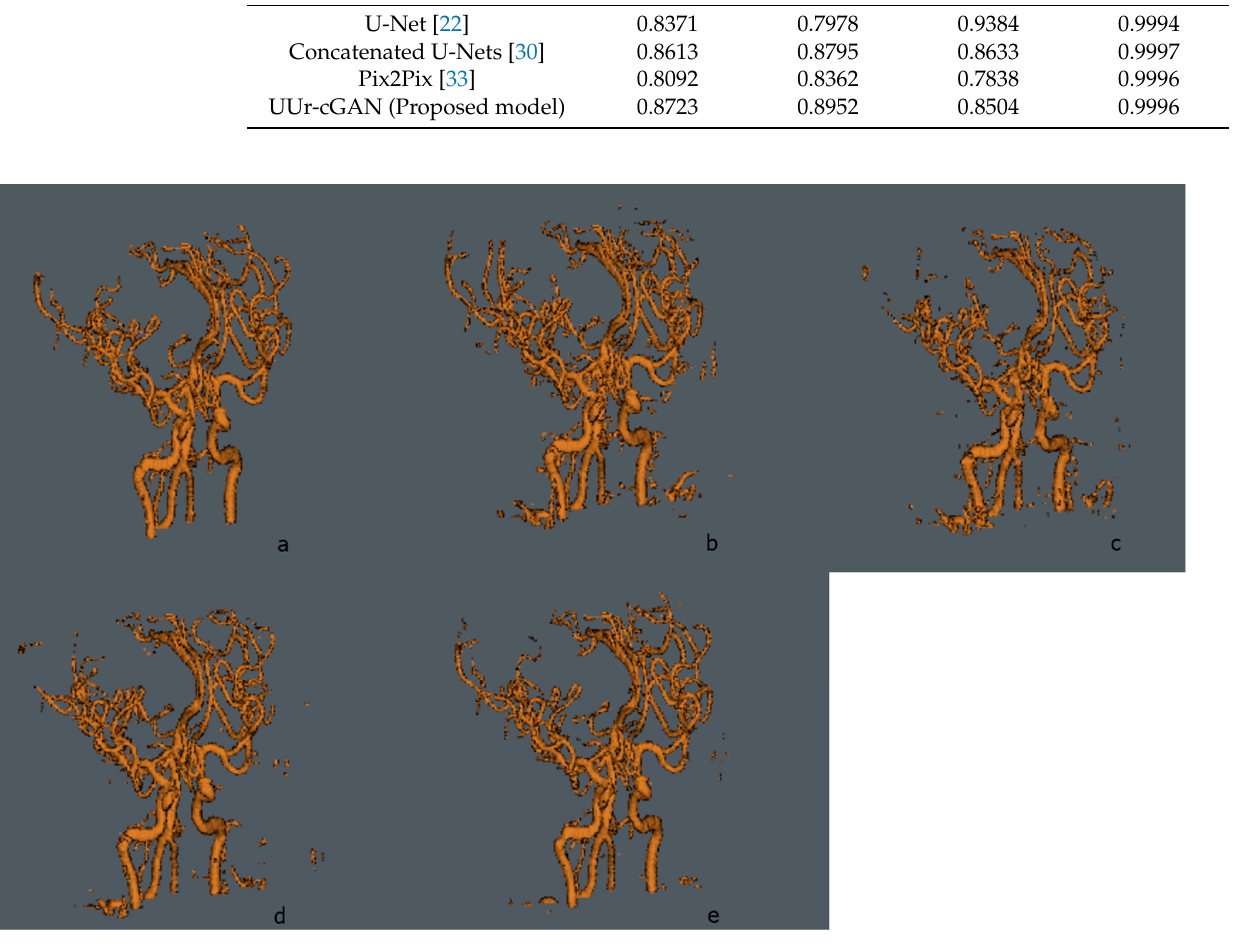
Figure 8. Error maps obtained from the difference between the ground truth and the predicted seg- mentation maps from each of the evaluated models, using the same volume shown in Figure 7. Visualizations were generated by the software Aliza Medical Imaging ©, Bonn, Germany, and DI- COM Viewer. ( a ) U-Net [22], ( b ) Concatenated U-Net and residual U-Net [30], ( c ) Pix2Pix [33], and ( d ) Proposed cGAN.